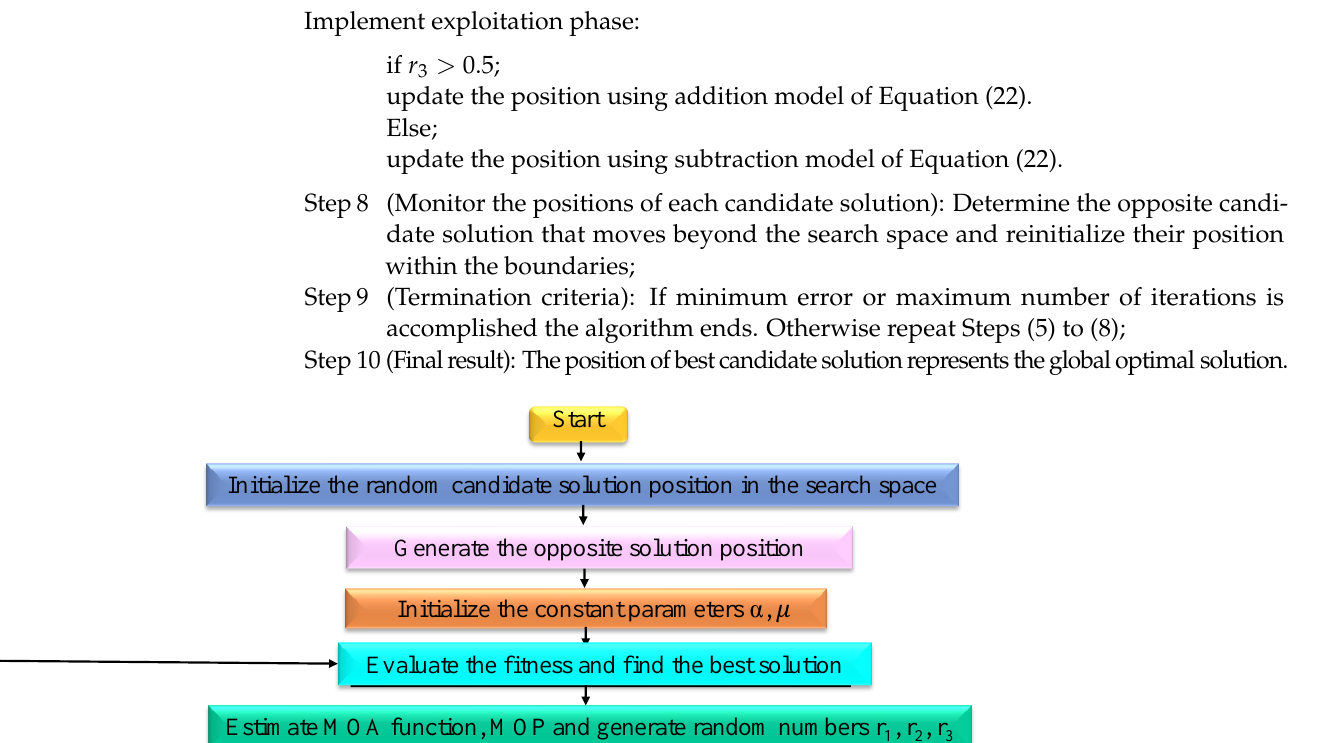
Start Initialize the random candidate solution position in the search space